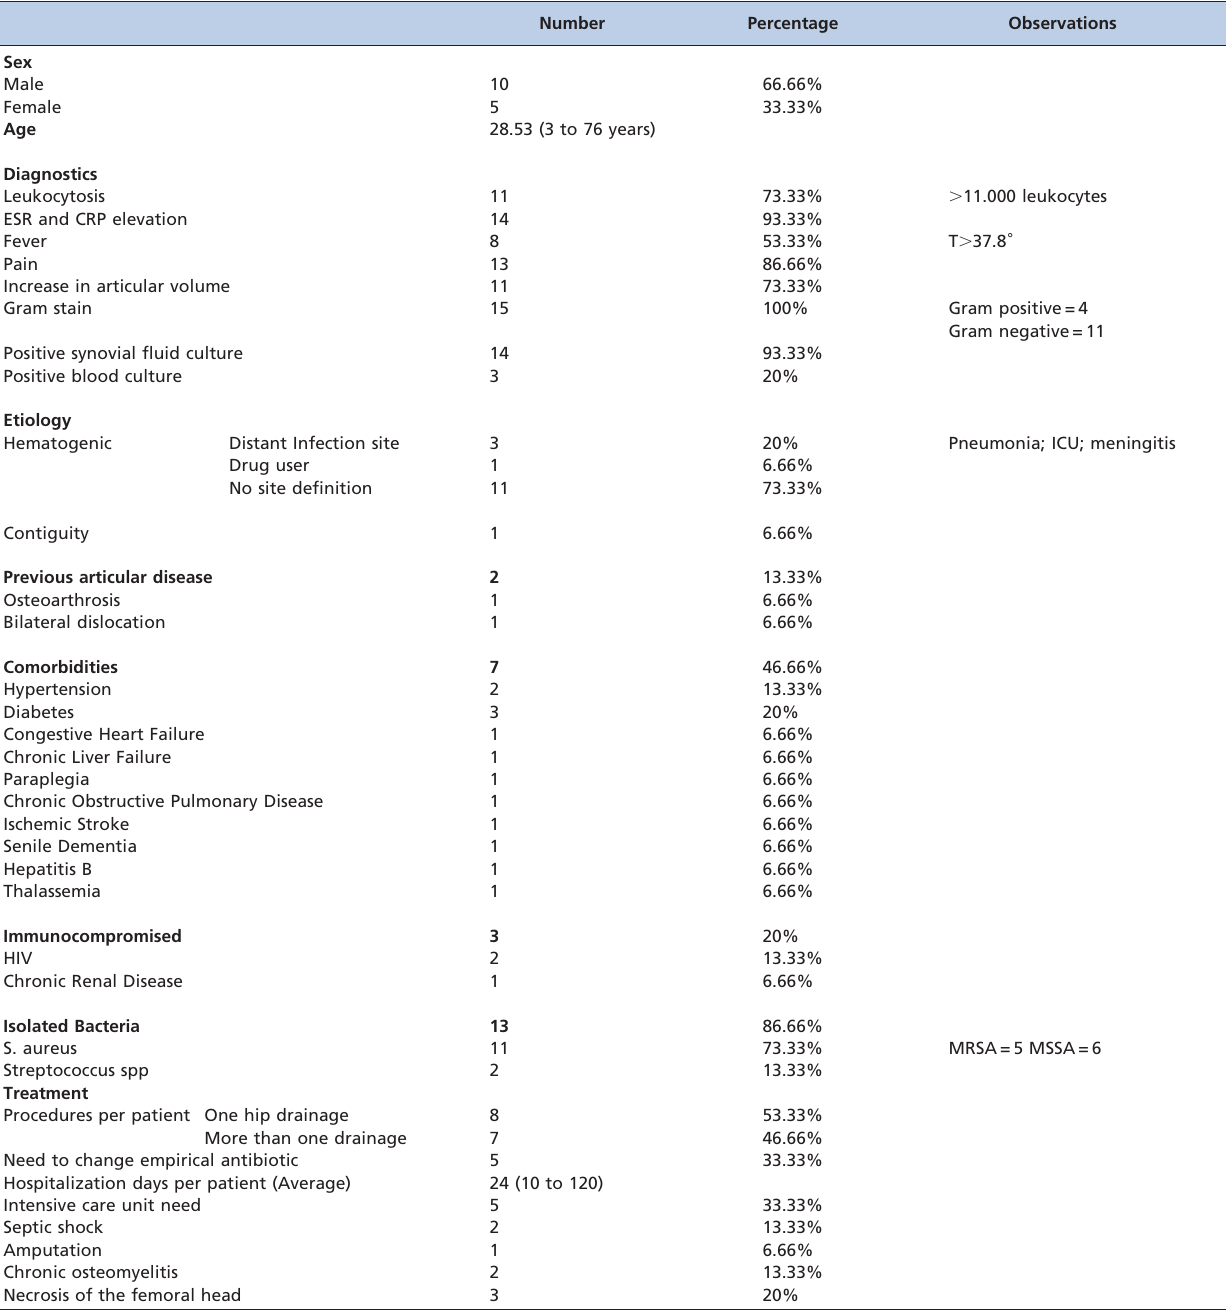
Table 1 - Epidemiological summary of study